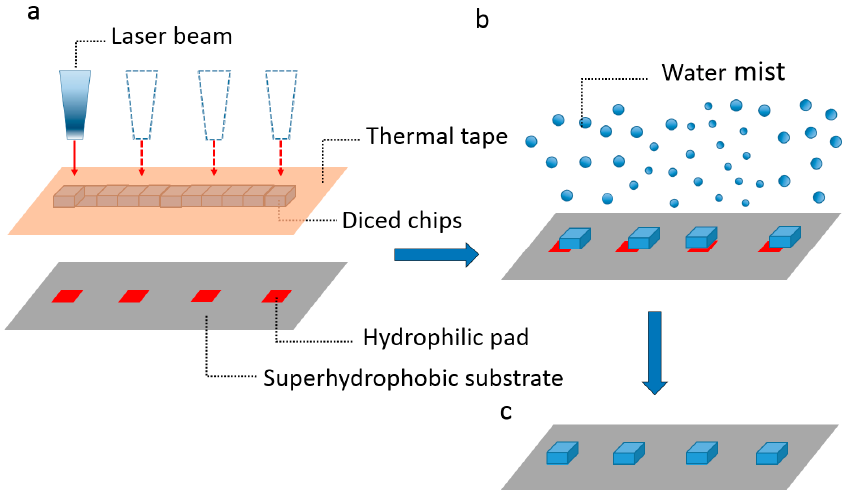
Figure 2. Procedure of laser-assisted mist capillary self-alignment: ( a ) chips were attached to a thermal release tape and a laser beam was pointed at the target chip; ( b ) the laser was fired and the target chips were released from the thermal tape and landed on the receiving receptor sites with an initial placement error; and ( c ) mist-induced micro droplets were delivered to the assembly sites and microchips were aligned to the corresponding receptor sites.